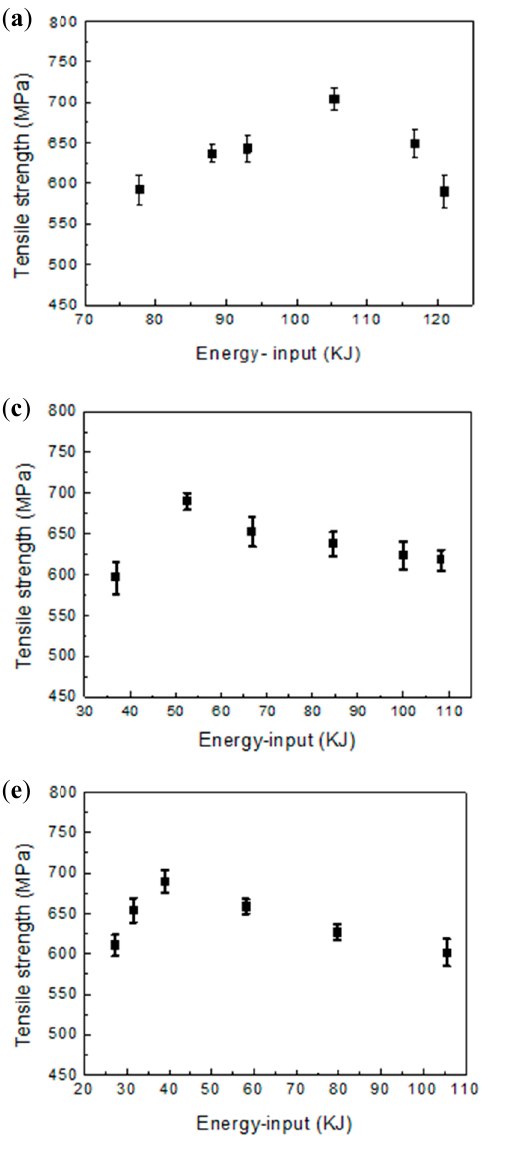
Figure 4. The variation trend of the 304SS RFW joint’s tensile strength with energy-input under forging pressures of ( a ) 100 MPa, ( b ) 120 MPa, ( c )140 MPa, ( d ) 160 MPa, ( e ) 180 MPa, and ( f ) 200 MPa. The bars associated with the tensile strength (the mean value of three tensile strength measurements) correspond to standard deviations. Table 1. Experiment parameters and the joint’s tensile strength under a forging pressure of 200 MPa. Friction Pressure Rotation No. Friction Time (MPa) Speed (rpm) No.